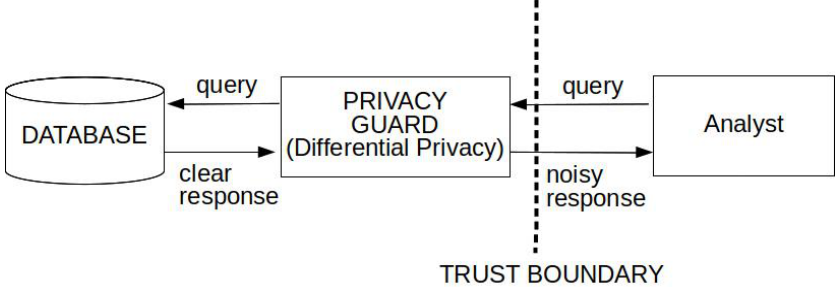
Figure 3. A simplified reference